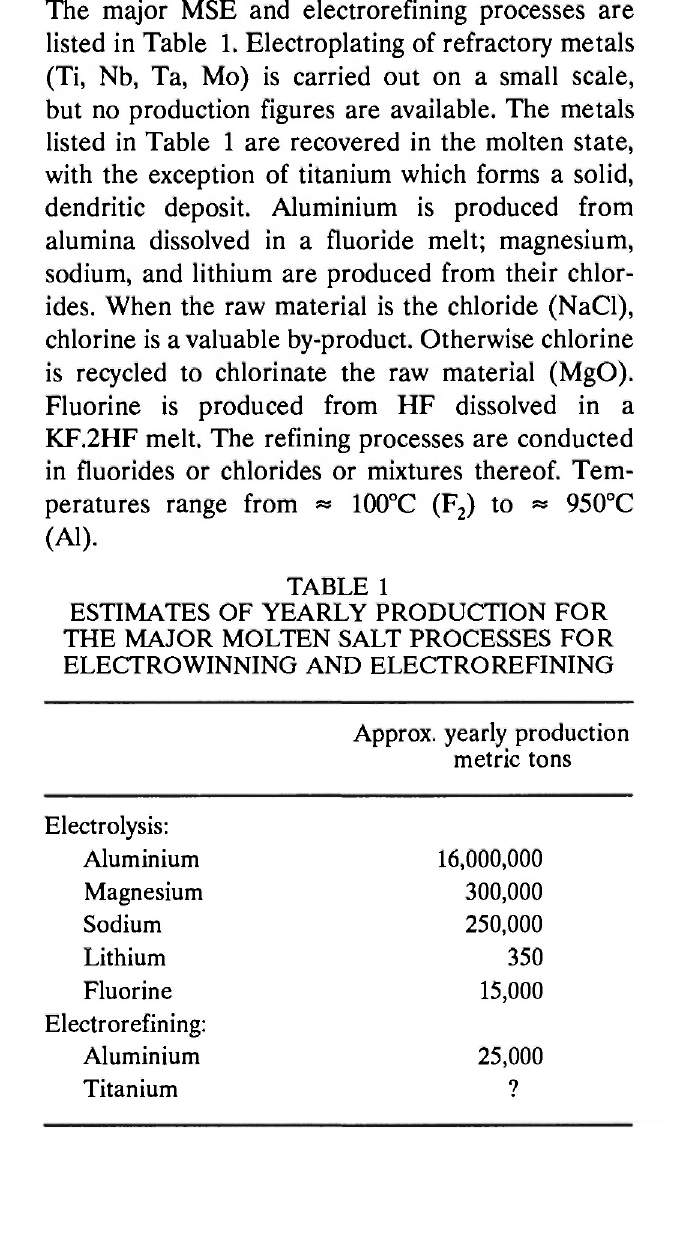
THE MAJOR MOLTEN SALT PROCESSES